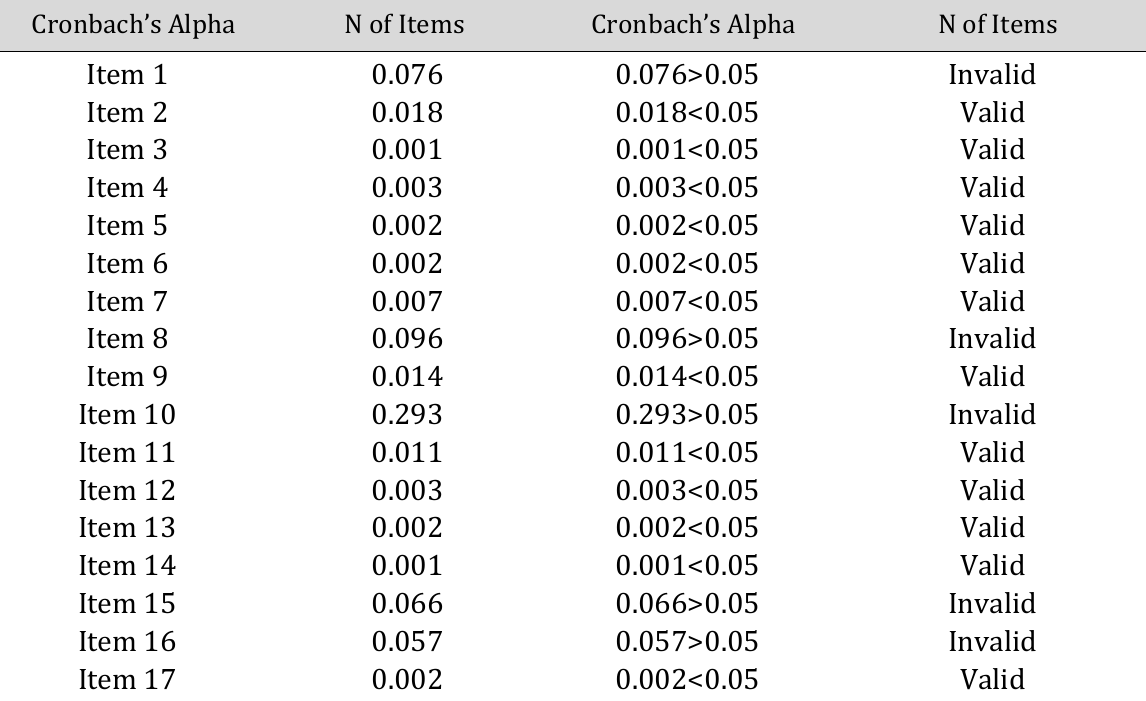
Table 6. The validity test for the students’ writing